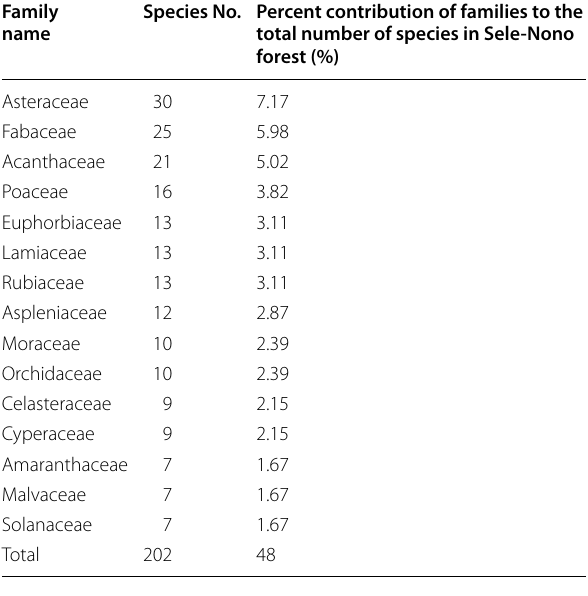
Table 2 Top fifteen species rich families recorded in Sele-Nono Forest